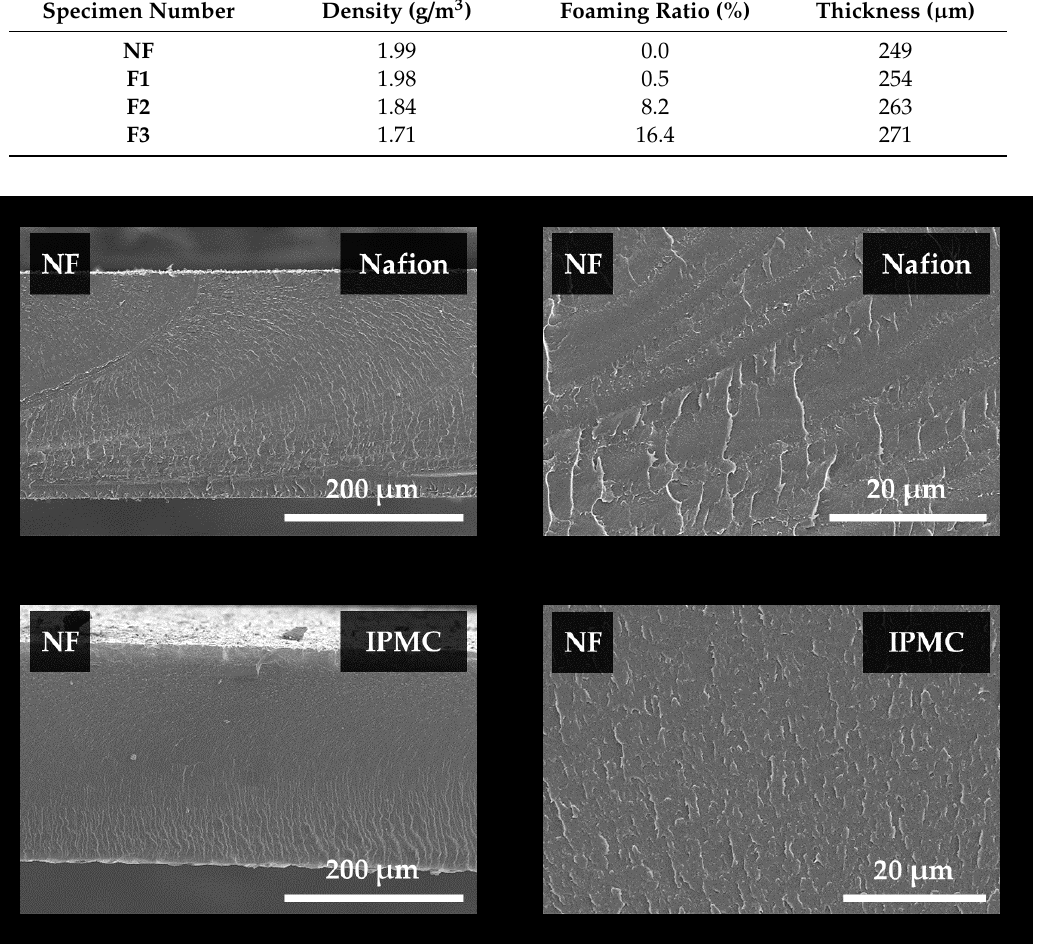
Figure 8. Scanning electron microscope observation images of cross sections of non-foamed Nafion and IPMC specimens.